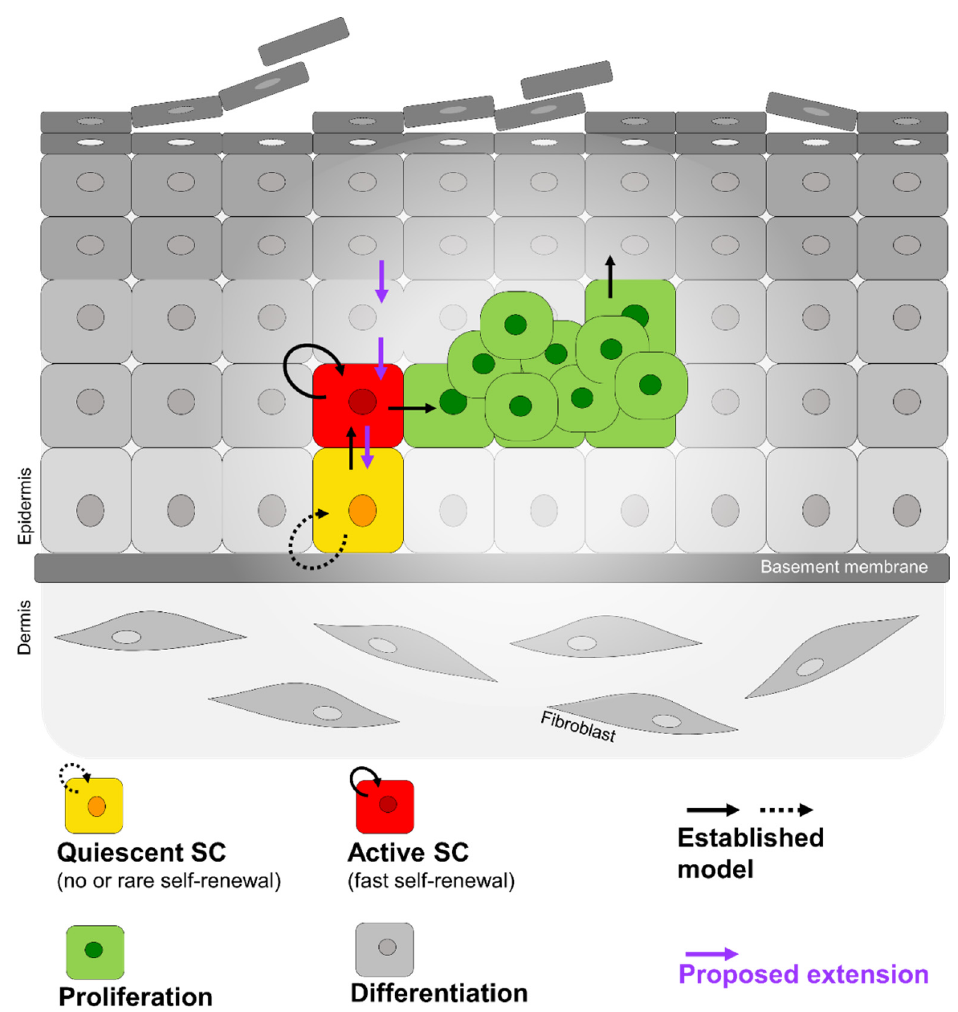
Figure 7. Quiescent and active stem cells assure epidermal self-renewal in human skin. Quiescent stem cells (yellow) residing in the basal layer of human interfollicular epidermis replace lost active self-renewing stem cells (red) present in the suprabasal layers. The active stem cell progeny (green) proliferate and differentiate to replenish the suprabasal keratinocyte layers. In addition, we propose that in a wound situation or triggered by the contact with the basement membrane, suprabasal not yet irreversibly differentiated keratinocytes (grey) can retro-differentiate into active or even quiescent SC (violet